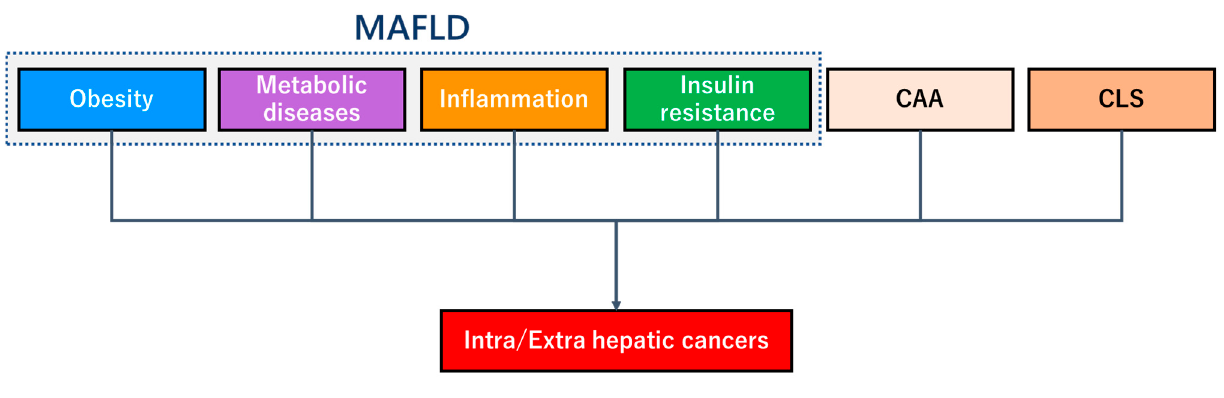
Figure 3. Major pathological mechanisms of multiorgan carcinogenesis. The dotted line indicates features of MAFLD. Abbreviations: MAFLD, metabolic abnormality-associated fatty liver disease; CAA, cancer-associated adipocytes; CLS, crown-like structures.